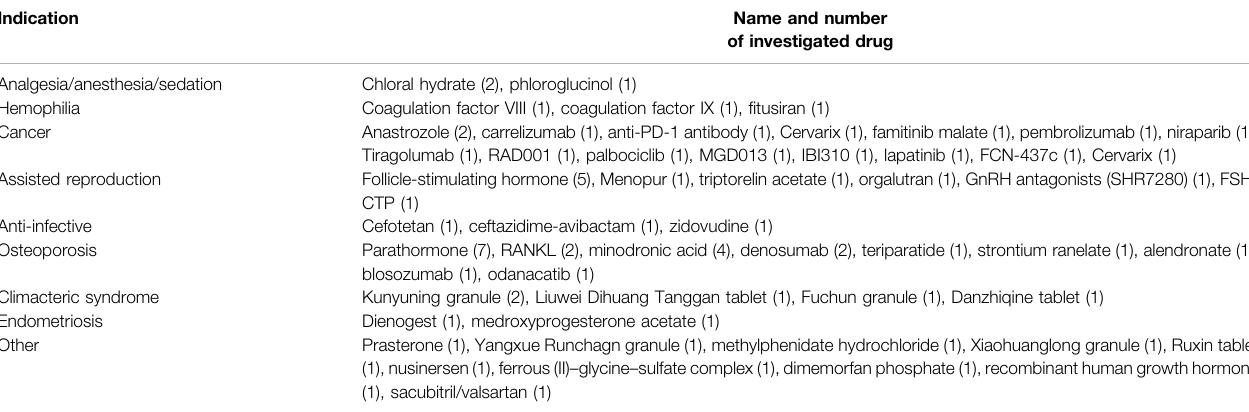
TABLE 5 | Overview of investigated drugs.